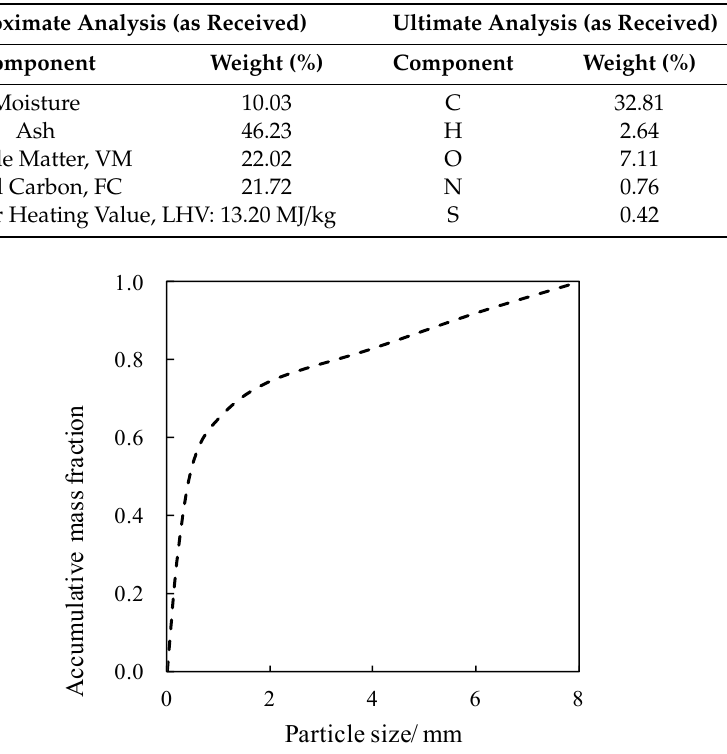
Figure 3. Size distribution of coal particles.